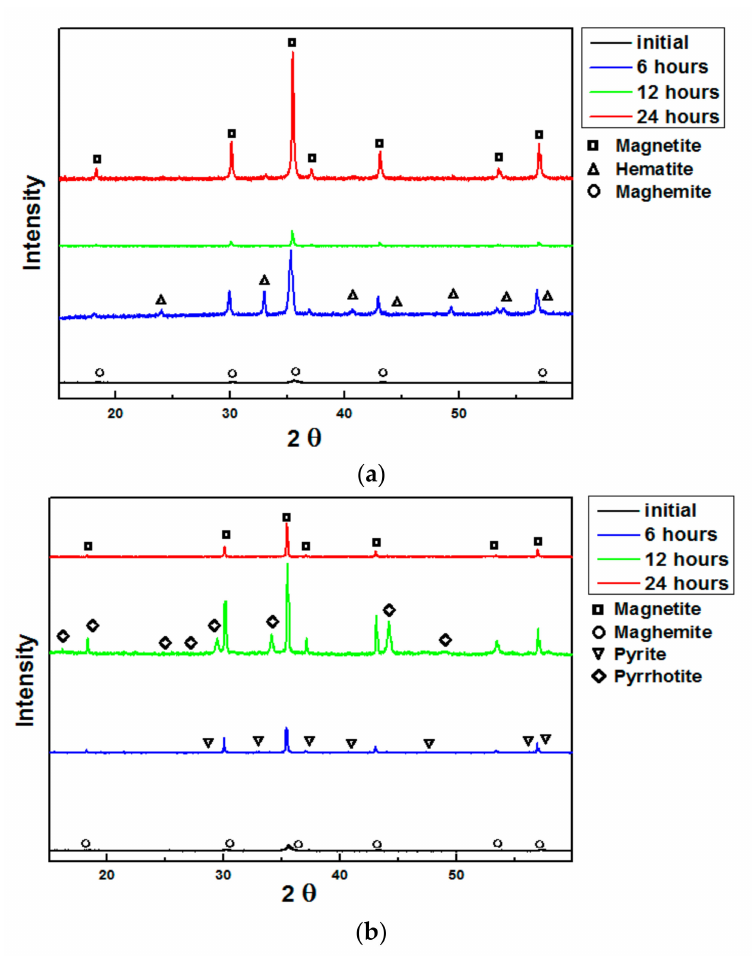
Figure 3. XRD patterns of catalyst particles after experiments (( a ) 250 ◦ C, ( b ) 300 ◦ C).